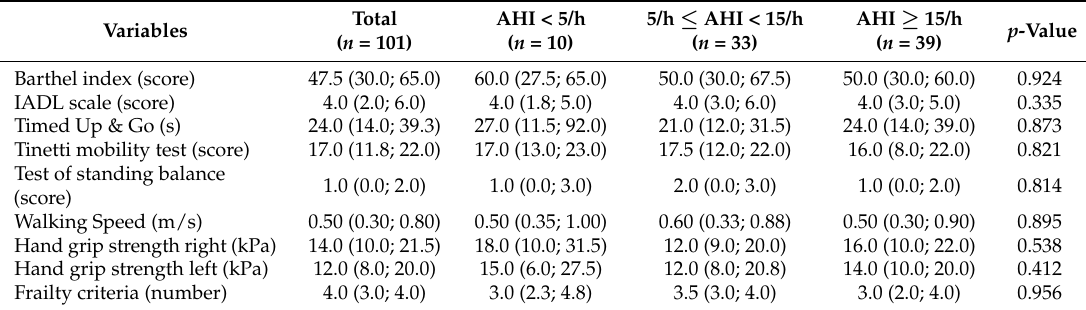
Table 4. Mobility also split by AHI